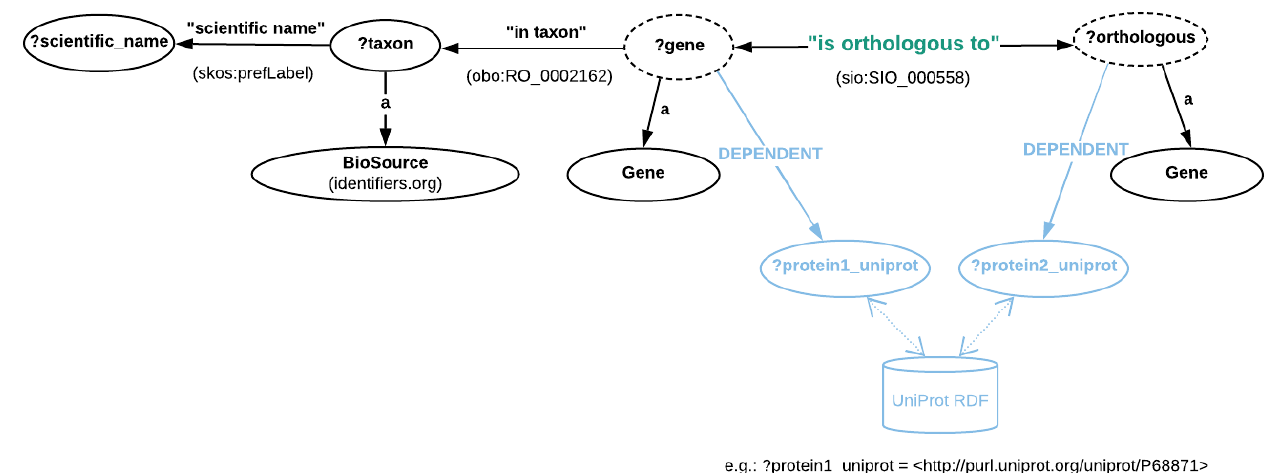
Figure 5. Directed graph abstraction of a portion of the EBI RDF graph related to pairwise orthologous genes. Moreover, as opposed to the RDF representations in OMA and MBGD, here the pairwise orthology is explicitly asserted through the “is orthologous to” property (more precisely, http://semanticscience.org/resource/SIO_000558) as shown in Figure 5. However, there is no information available regarding orthologous clusters. Moreover, the Gene class here is in fact the OBO (not ORTH) class, i.e. http://purl.obolibrary.org/obo/SO_0000704. Instances of these genes can be specified either through their cross-reference to UniProt (the http://rdf.ebi.ac.uk/terms/ensembl/DEPENDENT property) or directly through their ENSEMBL identifier, by fixing the value of ?gene to the concatenation of http://rdf.ebi.ac.uk/resource/ ensembl/ and the corresponding Ensembl identifier. Finally, the taxonomic identifiers are provided via instances of the BioSource class, http://